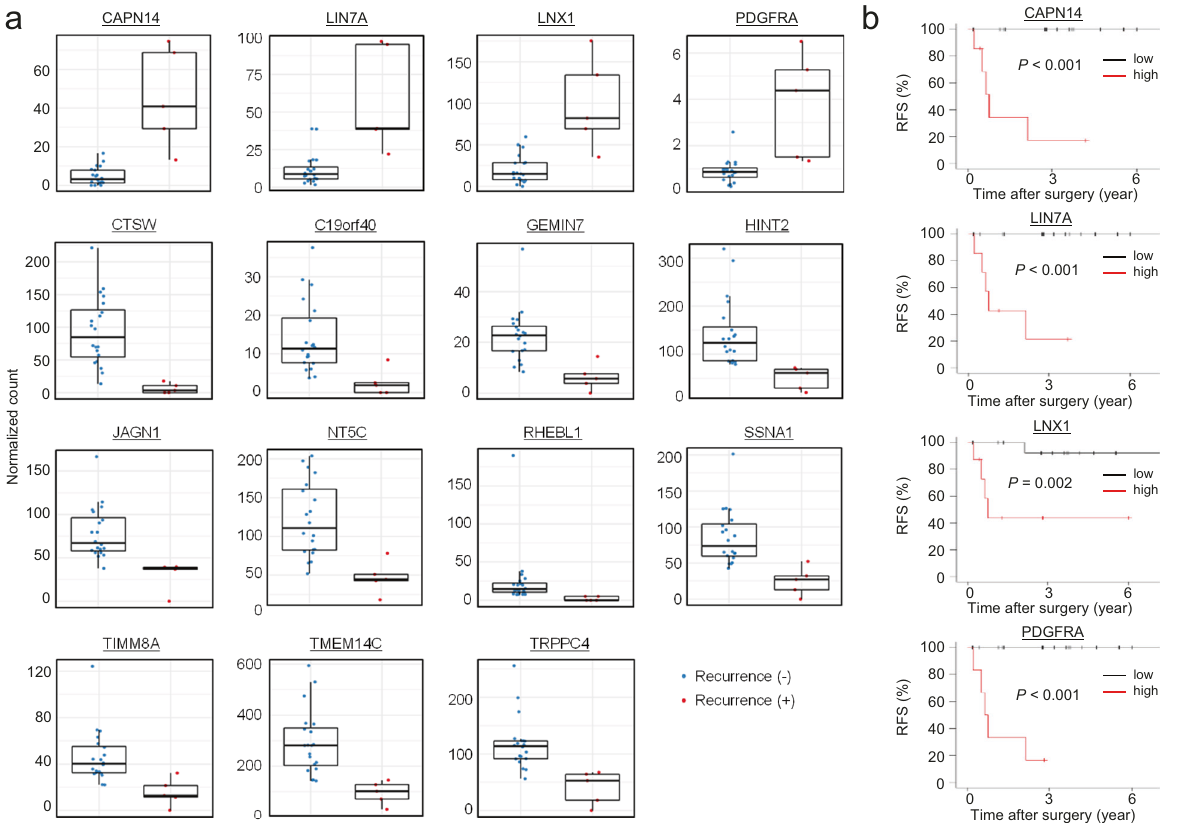
Fig. 3 RNA expression in pathological stages I and II pulmonary pleomorphic carcinomas. a The expression level of each gene was calculated and normalized using the DESeq2 package. The association between the RNA expression of each gene and recurrence-free survival (RFS) of 25 patients with pathological stage I or II PPC was assessed using univariate Cox proportional hazard regression model, showing the expression levels of the 15 genes strongly correlated with RFS ( q < 0.05). The midline in each box represents the median, and the lower and upper boundaries indicate the fi rst and third quartiles, respectively. Whiskers represent the 95% con fi dence intervals of the mean values. b Kaplan – Meier analysis of RFS of 25 patients according to the average RNA level of each gene demonstrated that strong expression of four genes was associated with shorter RFS ( p <